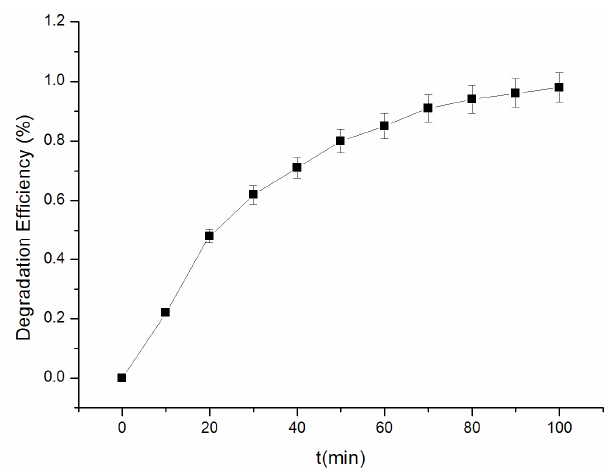
Figure 10. Degradation of acetochlor by the synergetic effect of the Fenton-like reaction and photocatalysis.